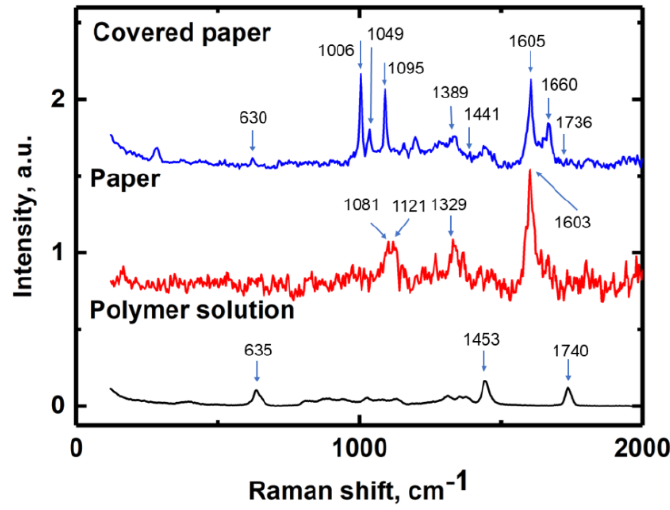
Figure 5. Raman spectra of paper base, PEVA (polymer) solution, and paper coated by PEVA. Arrows mark Raman shifts of main functional groups.